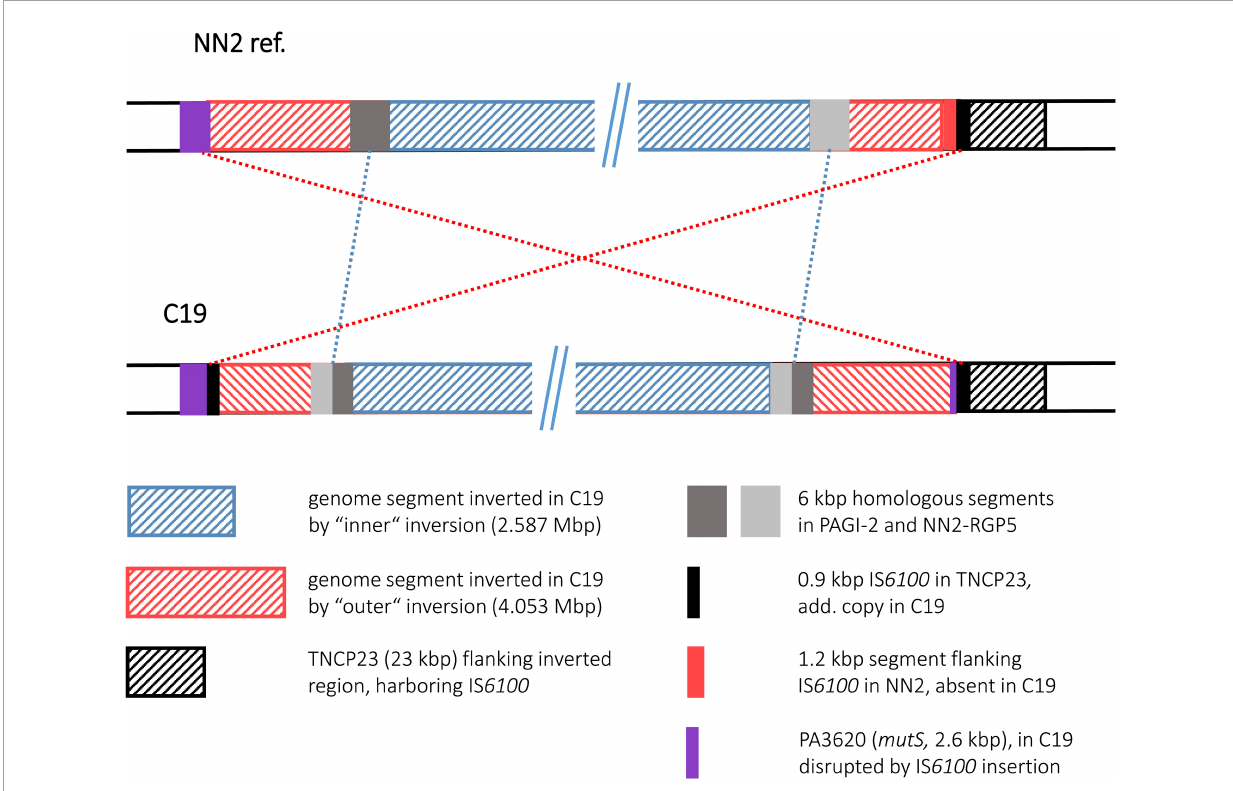
FIGURE7 Genomic inversions in strain C19. This figure illustrates the two large inversions detected in in the C19 sequence. The inversions are shown as “inner” and “outer” events, as the genome segment of the smaller inversion was also part of the segment affected by the larger event.